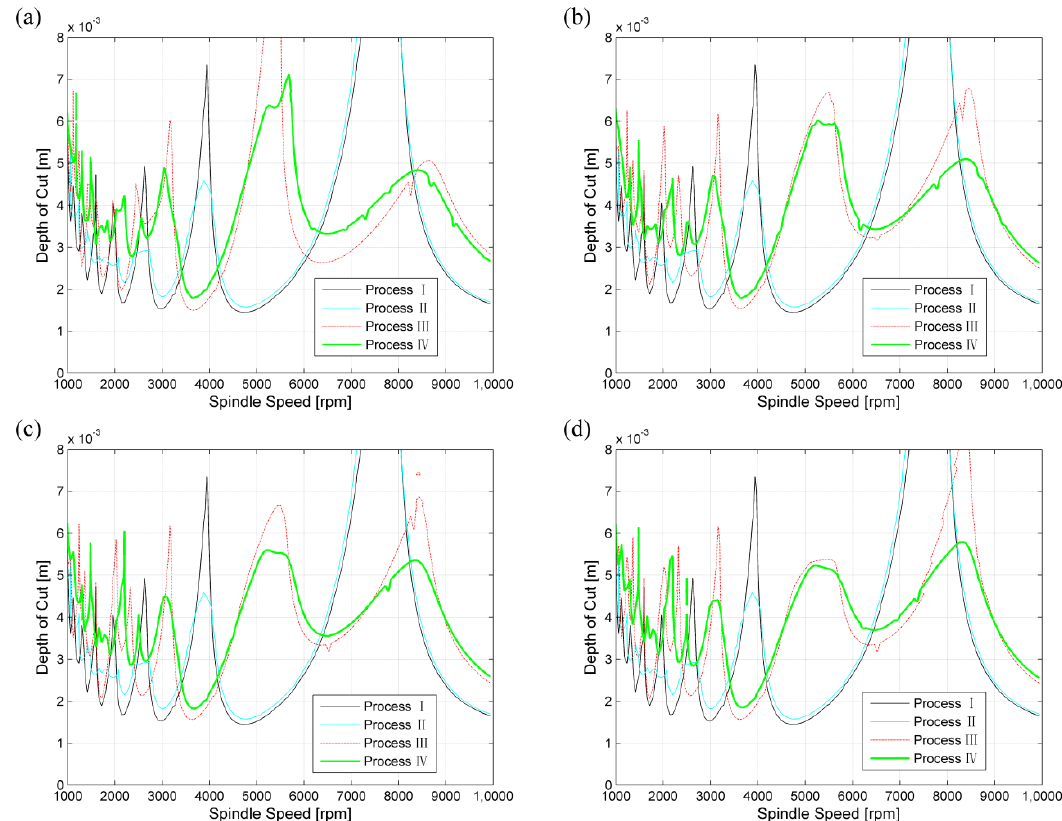
Figure 8. Comparisons of the SLDs associated with Processes I, II, III, and IV for the 2-DOF system. Note that the SLDs for Processes III and IV are plotted under the conditions of the same pitch angles ( ψ = [70, 110, 70, 110]°) but different helix angles: ( a ) β = [30, 30, 30, 30]°; ( b ) β = [32, 30, 32, 30]°; ( c ) β = [34, 30, 34, 30]°; and ( d ) β = [36, 30, 36, 30]°.